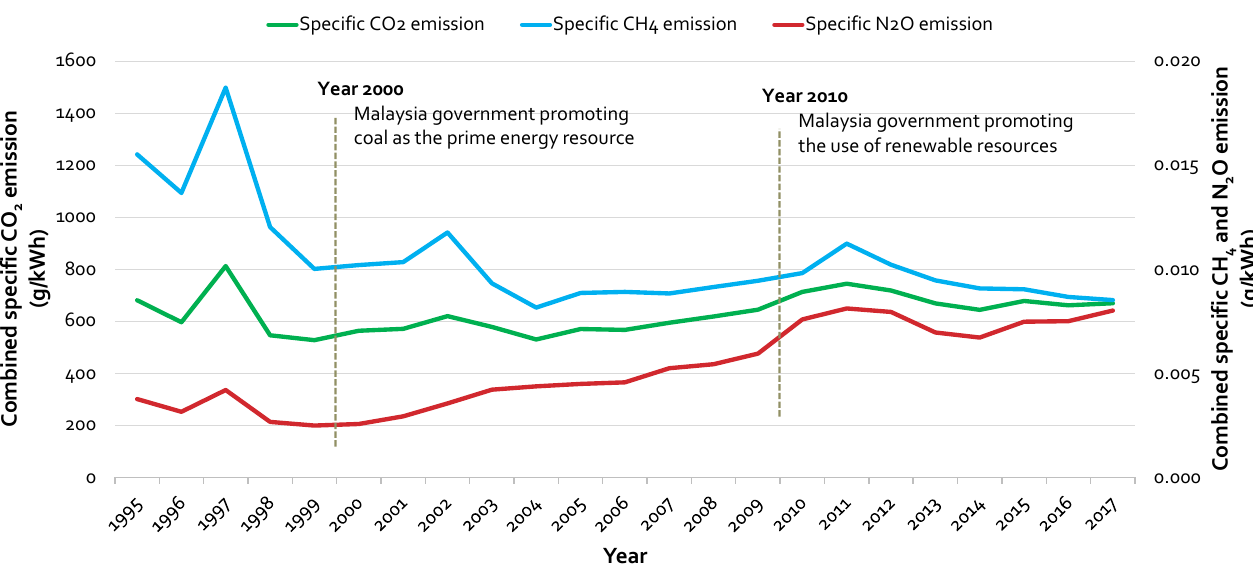
Figure 14. Combined specific emission from Malaysia electricity generation sector from 1995 to